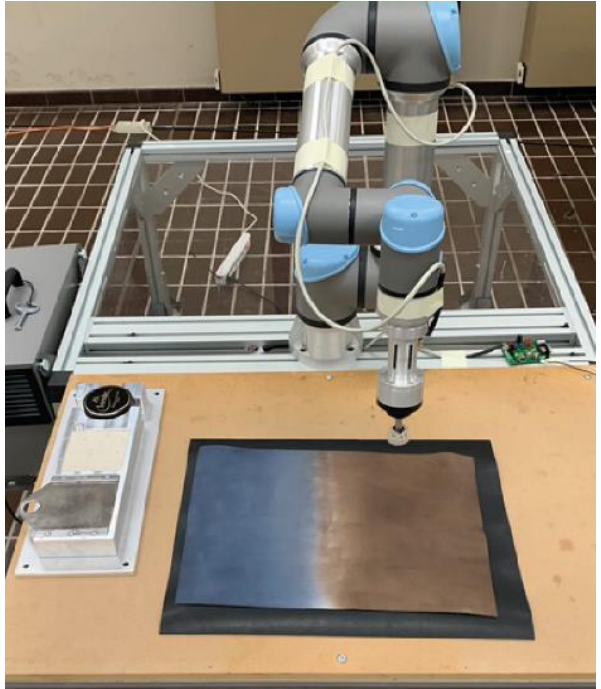
Figure 16. Robotic polishing station.